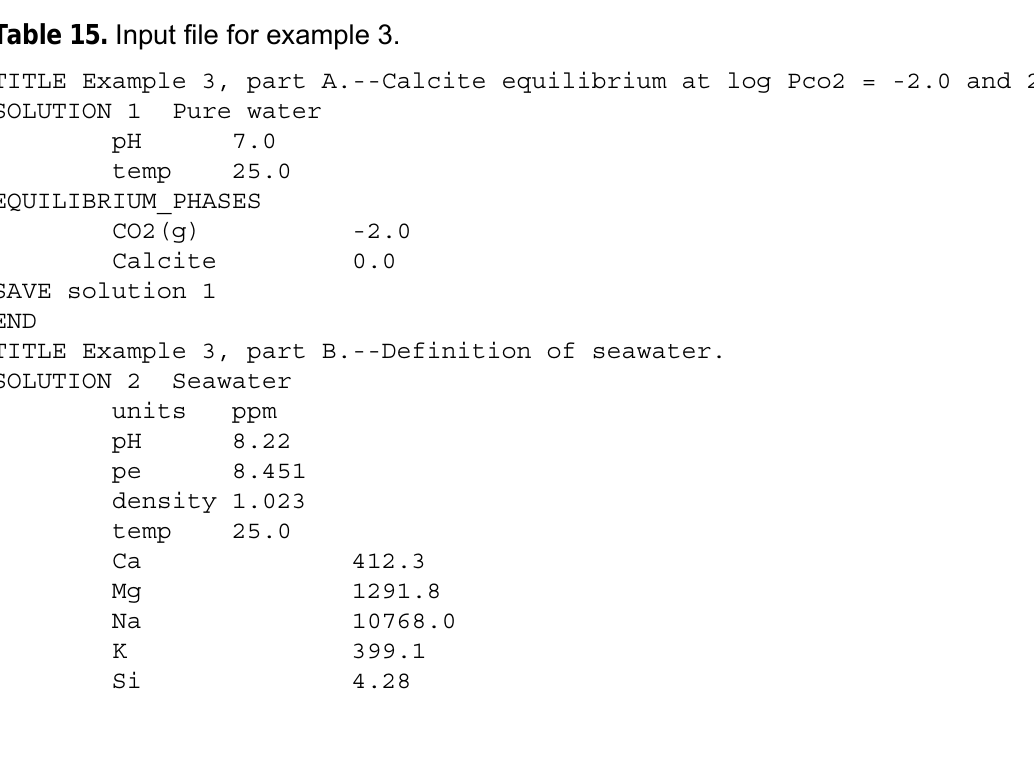
Table 15. Input file for example